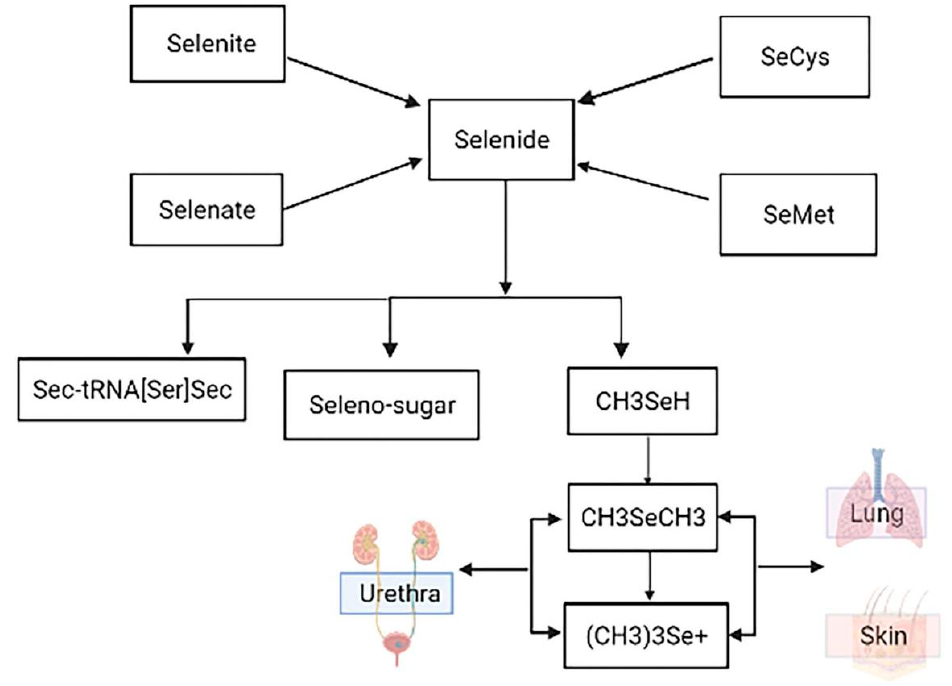
Figure 2. Metabolism of Se